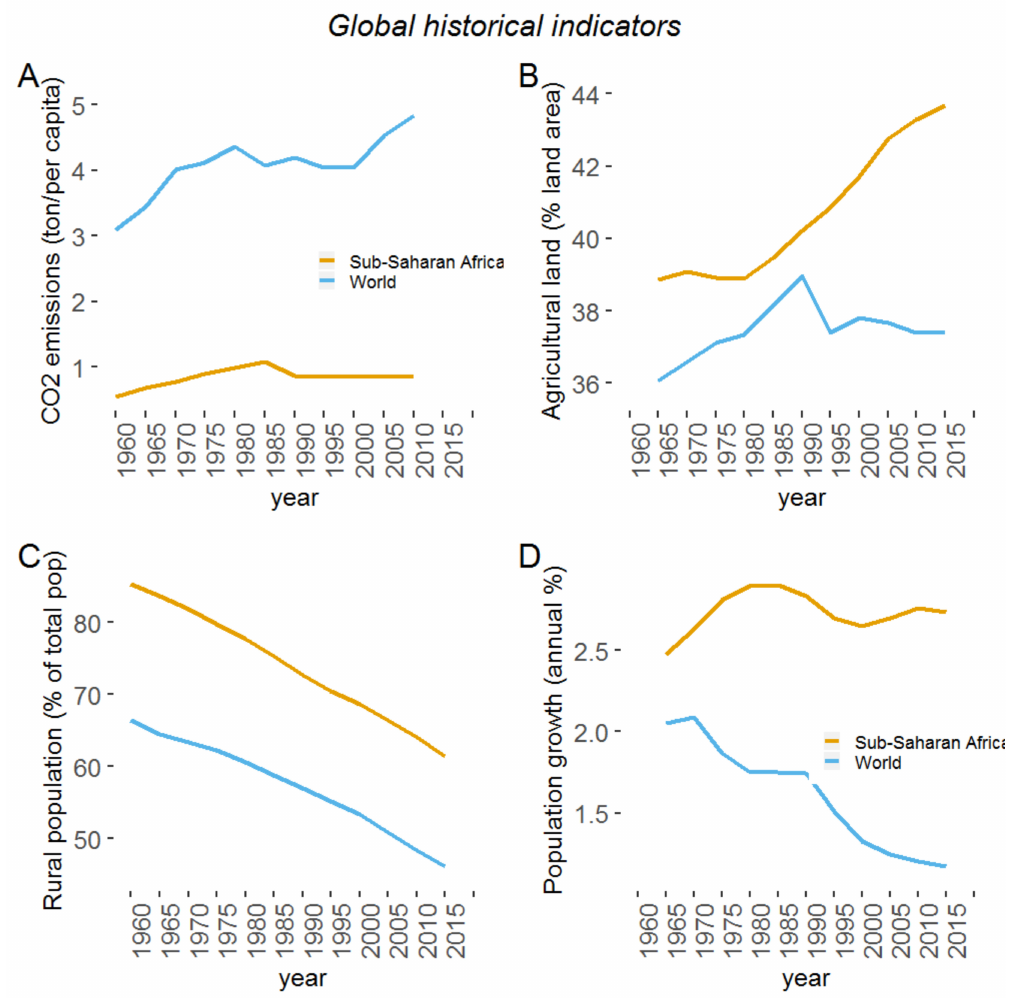
Figure 1. Comparison of global historical indicators (1960–2015) between Africa and the rest of the world for: ( A ) CO 2 emissions, ( B ) agricultural land, ( C ) rural population and ( D ) population growth. (Source: World Bank,